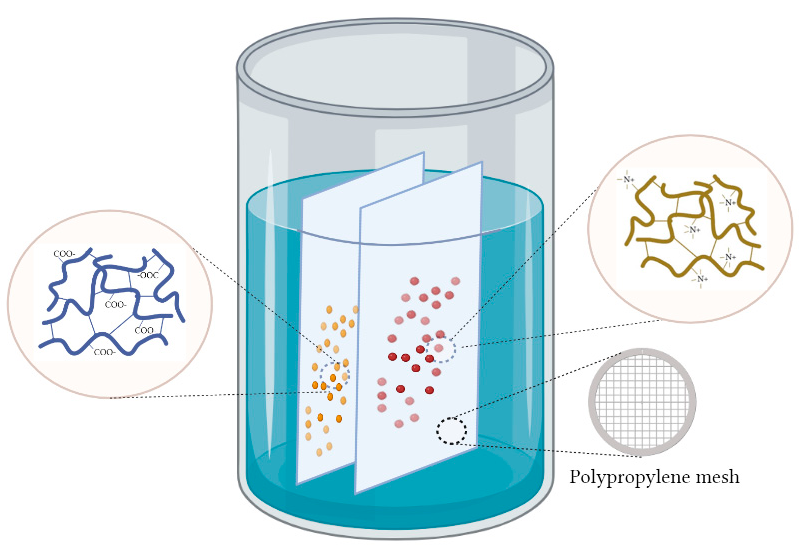
Figure 4. Illustration of the activation process of the “Lewatit CNP LF:AV-17-8” (X:Y) interpolymer system by remote interaction in an aqueous solution.